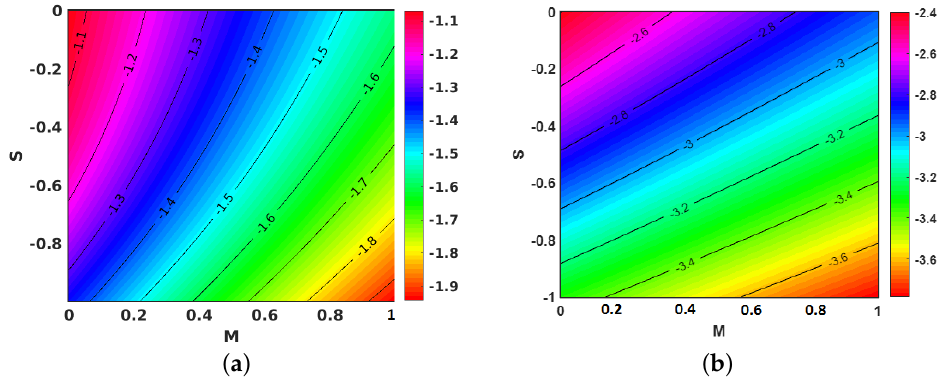
Figure 9. Effect of unsteadiness parameter ( S ) and magnetic parameter ( M ) on f (cid:48)(cid:48) ( 1 ) . ( a ) Injection; ( b ) suction.